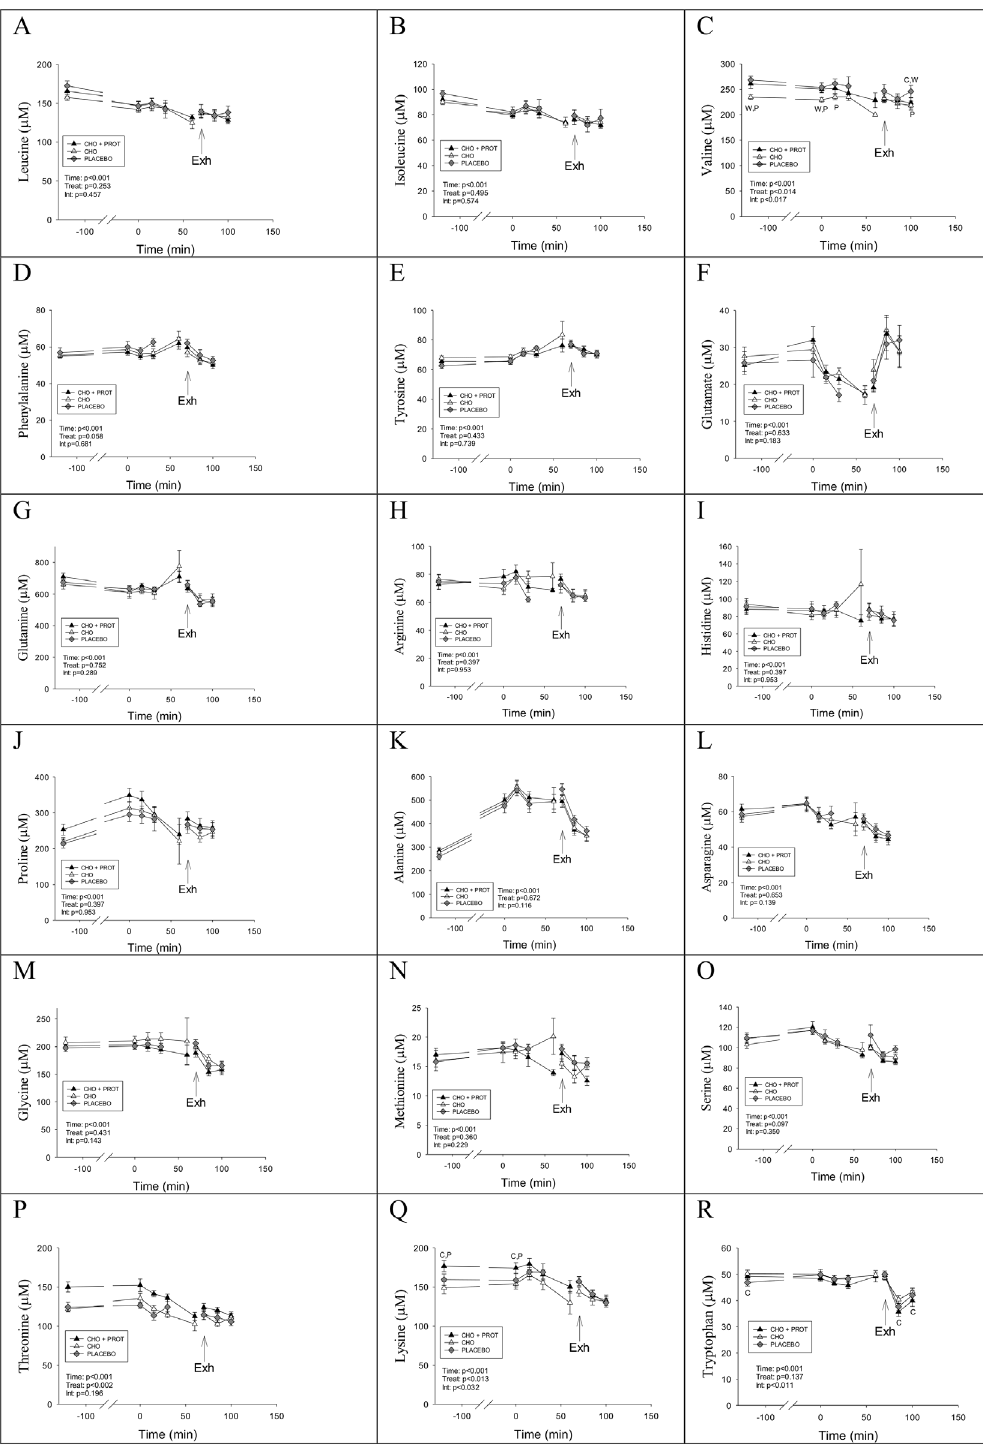
Fig 7. Concentrations of amino acids in fasted condition the day after exhaustive exercise and diet interventions, and during and after the performance test. Data are mean and error bars represents SEM. C: p < 0.05 compared to CHO; W: p < 0.05 compared to CHO+PROT (whey); P: p < 0.05 compared to placebo. N = 8 for all data